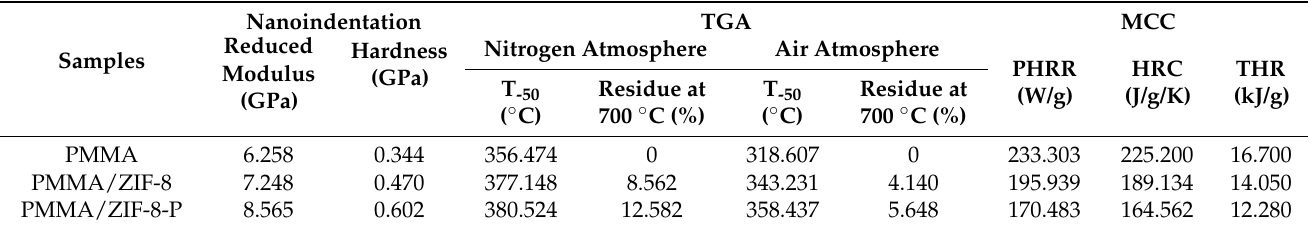
Table 1. Nanoindentation results for the TGA and MCC data for the PMMA, PMMA/ZIF-8, and PMMA/ZIF-8-P